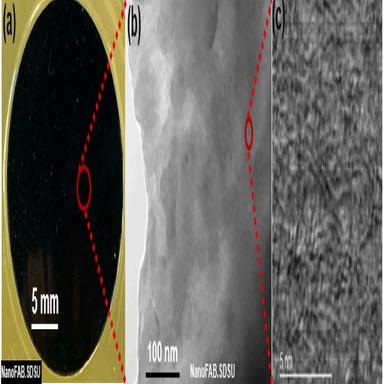
(a) Microfabricated GC electrode (2 cm Φ) (b) TEM image of GC (c) STEM image of GC. The interlayer distance between predominantly 5-, 6-, and 7-member carbon rings in GC = ~3 Å . (A colour version of this figure can be viewed online.)